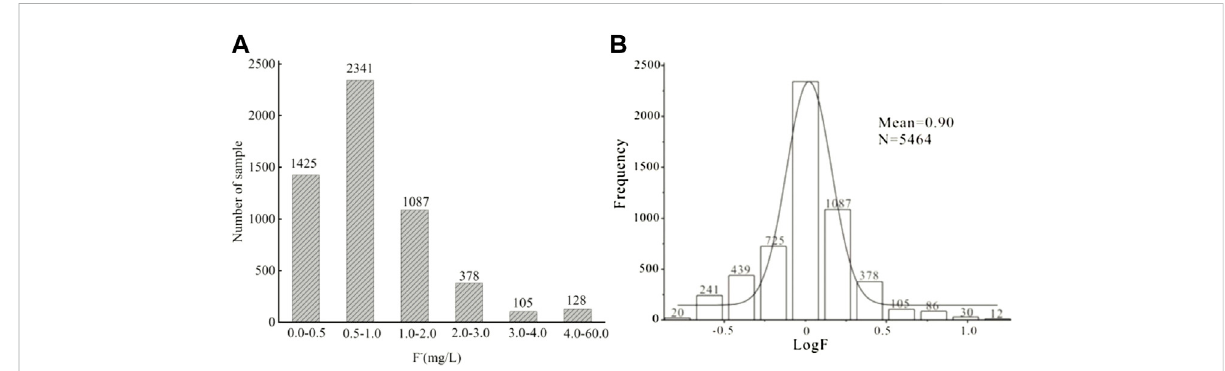
FIGURE 1 F- concentration histogram (A) and distribution (B) of shallow groundwater in China.